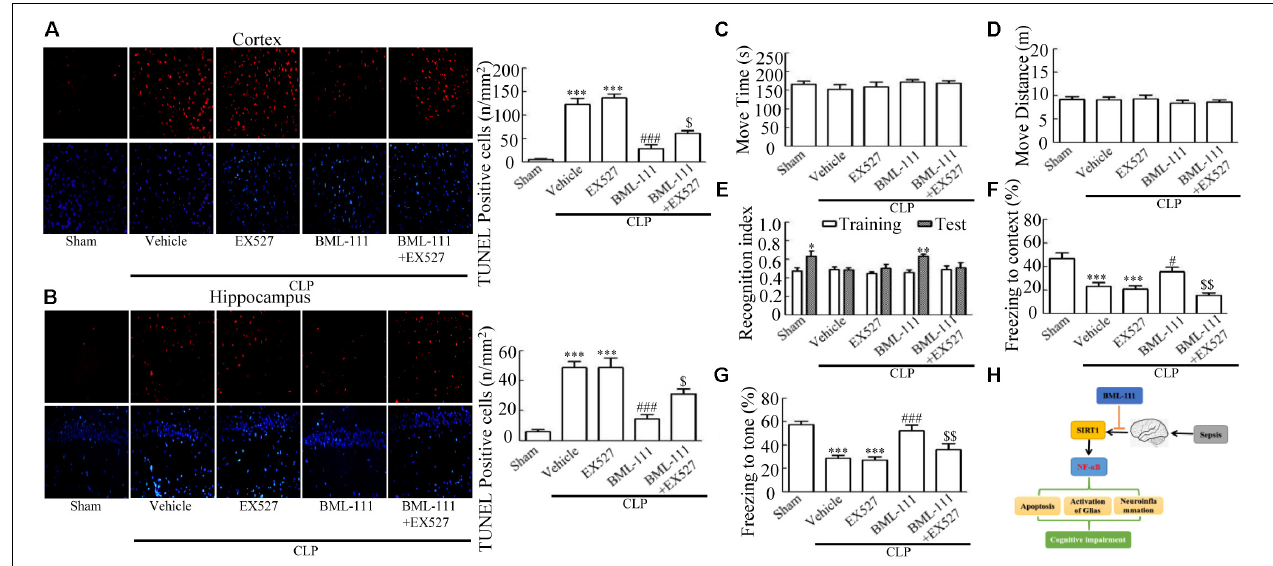
FIGURE 13 | BML-111 decreases the number of TUNEL-positive cells and cognitive impairment in CLP. (A,B) The number of TUNEL-positive cells in cortex and hippocampus were significantly increased in CLP + Vehicle and CLP + EX527 mice compared with the sham group. BML-111 treatment reversed this variation in CLP + Vehicle and CLP + EX527 mice, and EX527 administration prior to CLP and BML-111 reduced these effects. Scale bars indicate 20 mm ( n = 3 surviving mice per group). (E–G) EX527 treatment before CLP and BML-111 treatment decreased the recognition index for the new object when compared with the familiar one and decreased the freezing behaviors compared with the CLP + BML-111 group. (C,D) Move time and distance in the open-field-test. There was no difference among groups. (H) Schematic overview showing the involvement of BML-111 in sepsis-induced brain dysfunction. Data were shown as the means ± SEM ( n = 10 survived mice in C–G ). ∗ P < 0.05, ∗∗ P < 0.01 represent Test vs. Training in E . ∗∗∗ P < 0.001 represent CLP + Vehicle vs. Sham and CLP + EX527 vs. sham in A,B,F,G , # P < 0.05, ### P < 0.001 represent CLP + BML-111 vs. CLP + Vehicle in A,B,F,G , $ P < 0.05, $$ P < 0.01 represent CLP + BML-111 + EX527 vs. CLP + BML-111 in A,B,F,G